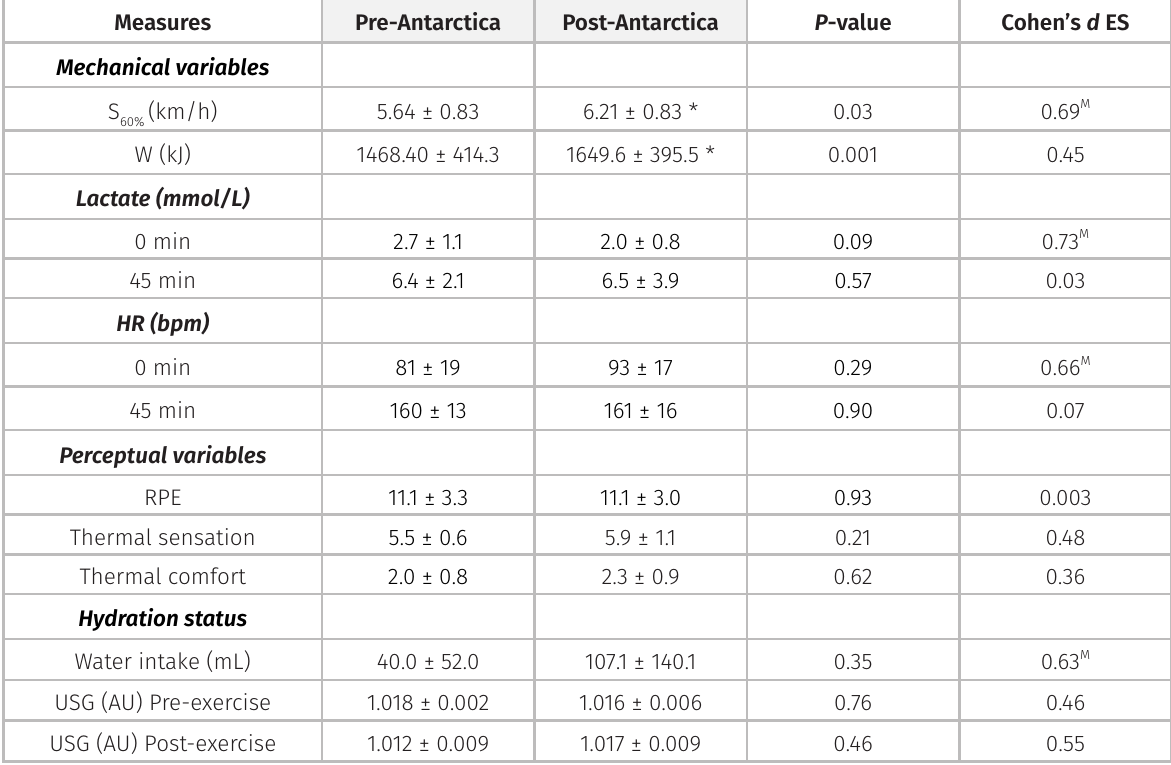
Table II. Mechanical variables, markers of exercise intensity and perceived exertion during the exercise heat stress protocol and hydration status assessed before and after the protocol in the pre-Antarctica and post-Antarctica